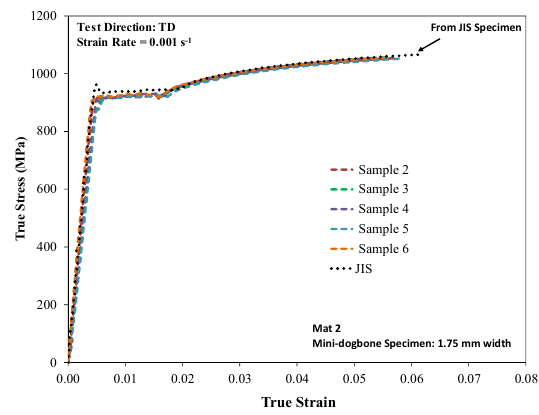
Fig. 6. Comparison of the average 0.001 s -1 results obtained with the JIS specimens with six tests performed with the MDB sample.